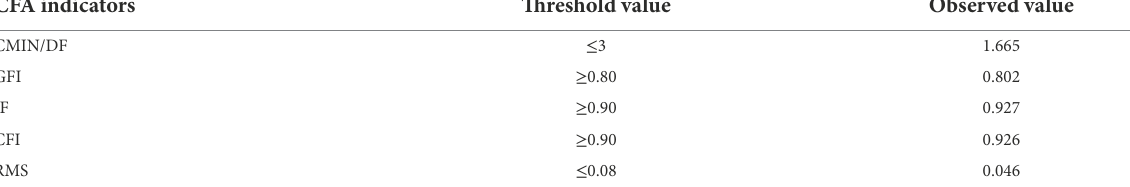
TABLE 6 Model fit indices.